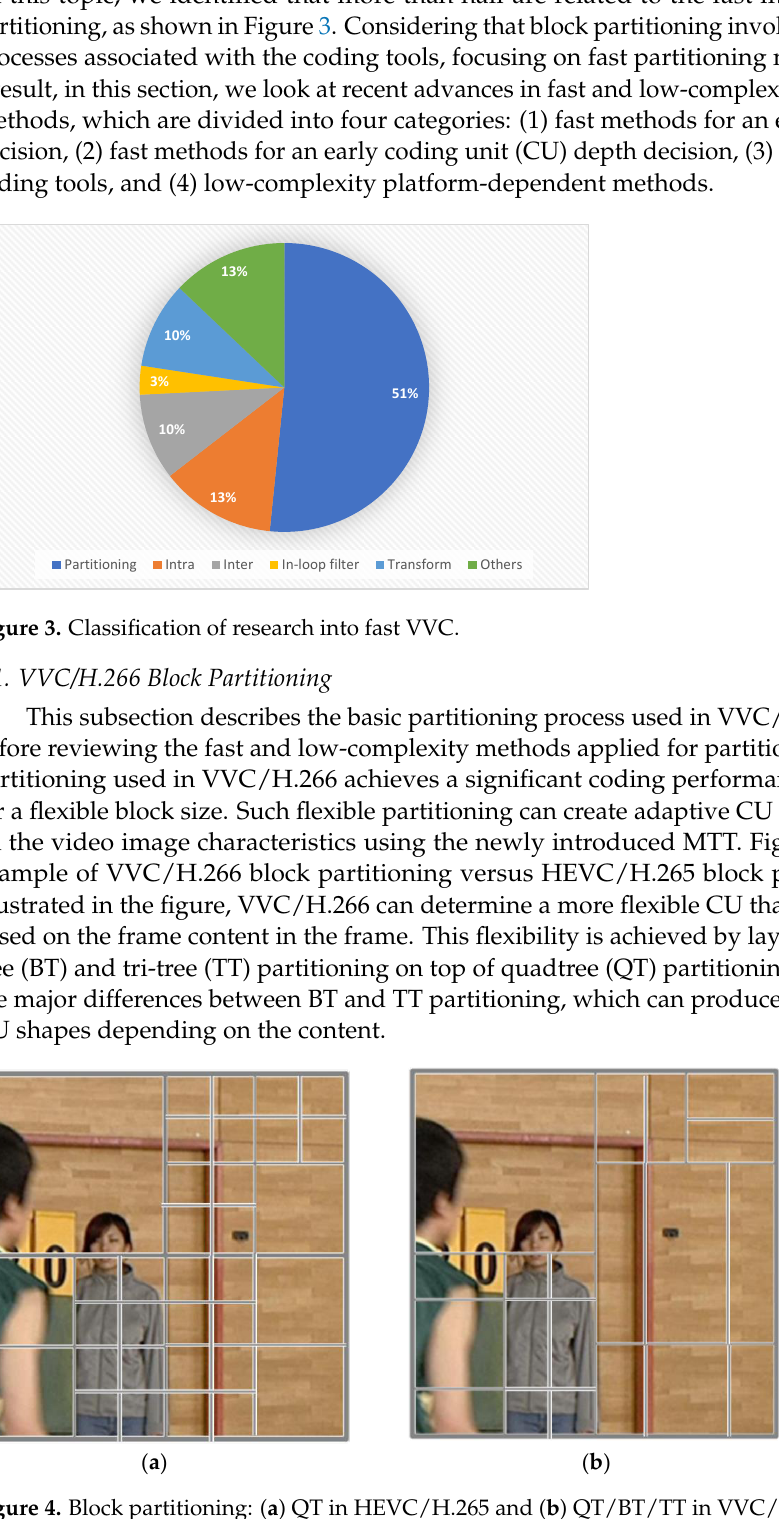
Figure 5. Flowchart of VVC/H.266 block partitioning. 3.2. Fast Method on Early Split Mode Decision The first approach is to investigate the split mode for an early split mode determina- tion or to skip some of the split modes in the mode evaluation. At a given depth, five split modes were evaluated in the VVC/H.266 partitioning, i.e., HBT, VBT, HTT, VTT, and QT. With this approach, the partitioning process involves a reduced number of evaluations to determine the split mode by skipping unnecessary evaluations at a given depth. This ap- proach saves a significant amount of encoding time by reducing computations in a skipped mode evaluation. The following studies were investigated from this perspective.